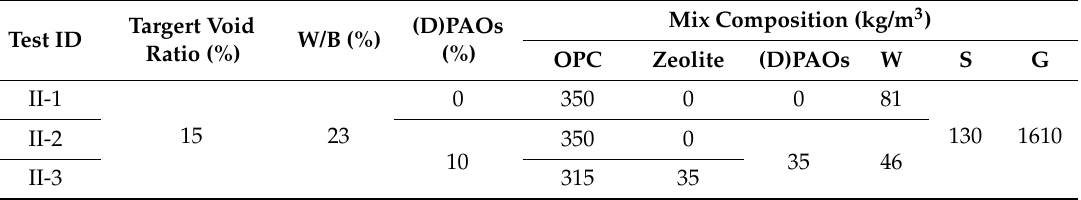
Table 6. Mix proportion of the porous concrete produced with (D)PAOs and zeolite.